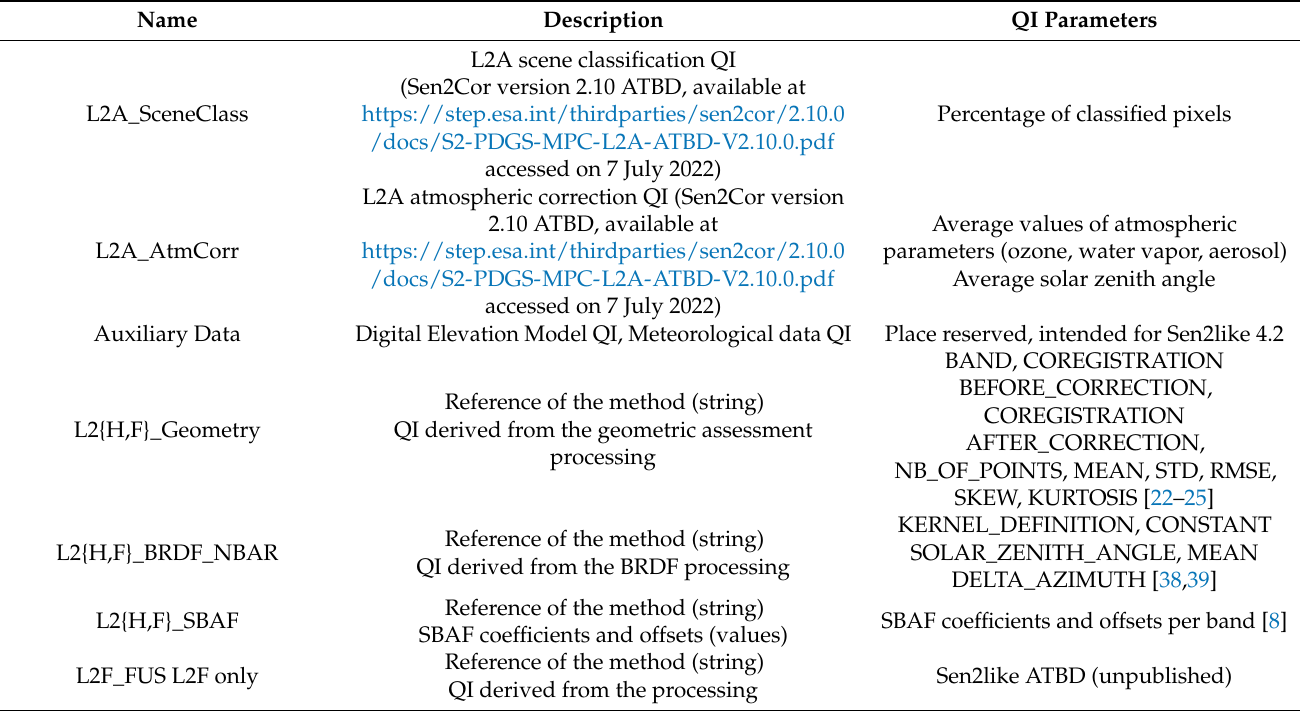
Table A4. Sen2Like QI data and